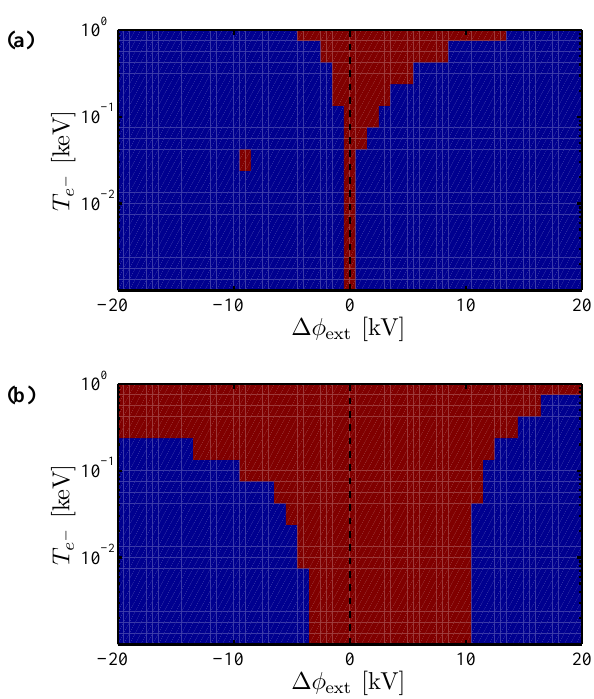
Fig. 7. Existence of a tangential discontinuity equilibrium be- tween (a) plasmas of different temperatures, while the left density is 0 . 1cm − 3 and temperatures vary from T e − = 1eV up to 1keV = 5 T for the electrons and T e − for the protons, while the right H + plasma consists of 1keV electrons and 5keV protons with a density of 0 . 5cm − 3 , and (b) two plasmas with the same temperatures, with left and right densities of 0 . 1cm − 3 and 0 . 5cm − 3 and with electron and ion temperatures varying through the same range as in panel (a) . In both cases the computations have been carried out over a broad range of EEPD values. The red regions indicate the existence of a tangential discontinuity; in the blue regions no tangential disconti- nuity equilibrium is